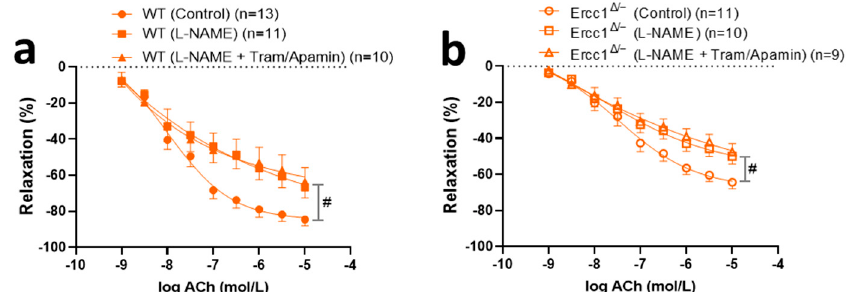
Figure 5. The impact of the NO synthesis inhibitor L-NAME (100 μ mol/L) and EDH inhibitors TRAM34 (10 μ mol/L) and apamin (100 nmol/L) on the relaxations induced by ACh in aortic rings precontracted by U46619 in Ercc1 Δ / − mice ( b ) and WT littermates ( a ) treated with sildenafil. Data were calculated relative to the maximal changes from the contraction produced by U46619 in each ring, which was taken as 100%. Values are expressed as means ± SEM; n, number of mice; #, p < 0.05, GLM for repeated measures.